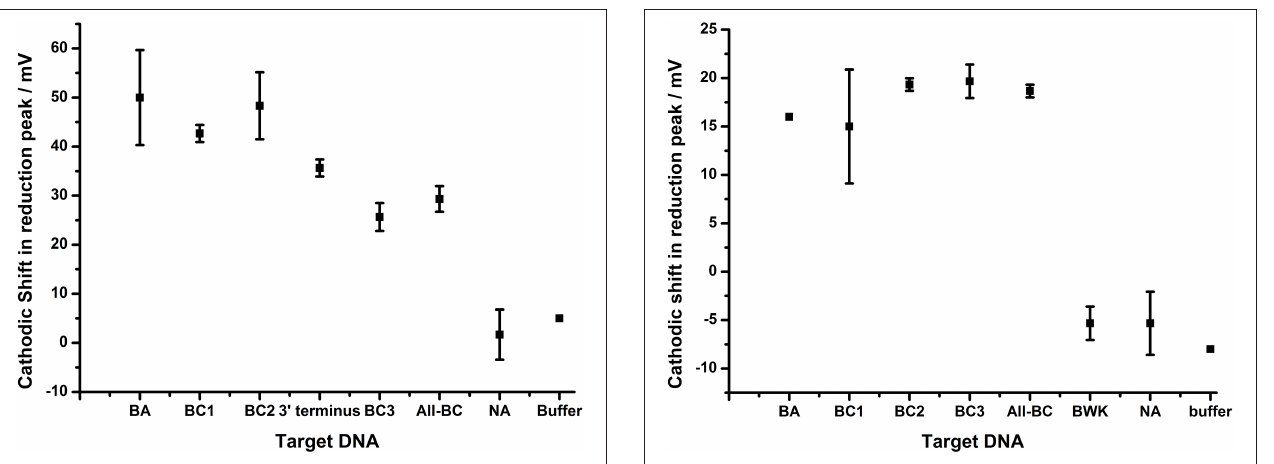
FIGURE 7 | Impact of terminal nucleotide on ability to distinguish base pair changes. Probe BA-1 was hybridized to target DNA that was fully homologous (BA) or contained 1 bp mutation toward the 5 ′ terminus of probe BA-1 (BC1), 2 bp mutations internal to the BA-1 probe (BC2), single base pair mutation at the 3 ′ terminus directly associated with the AQ tag (3 ′ terminus), two bp mutations including AQ terminal bp (BC2), a combination of all BC mutations (4 bp mutations All-BC), in comparison to controls NA and buffer only. All measurements were made by DPV (scan − 0.4V to − 0.75V; 50mV s − 1 ) vs. SCE in 10mM Tris buffer pH 8 containing 0.5M NaCl. Points represent an average of the responses shown by three replicate electrodes (error bars are 95% confidence limits from this mean).